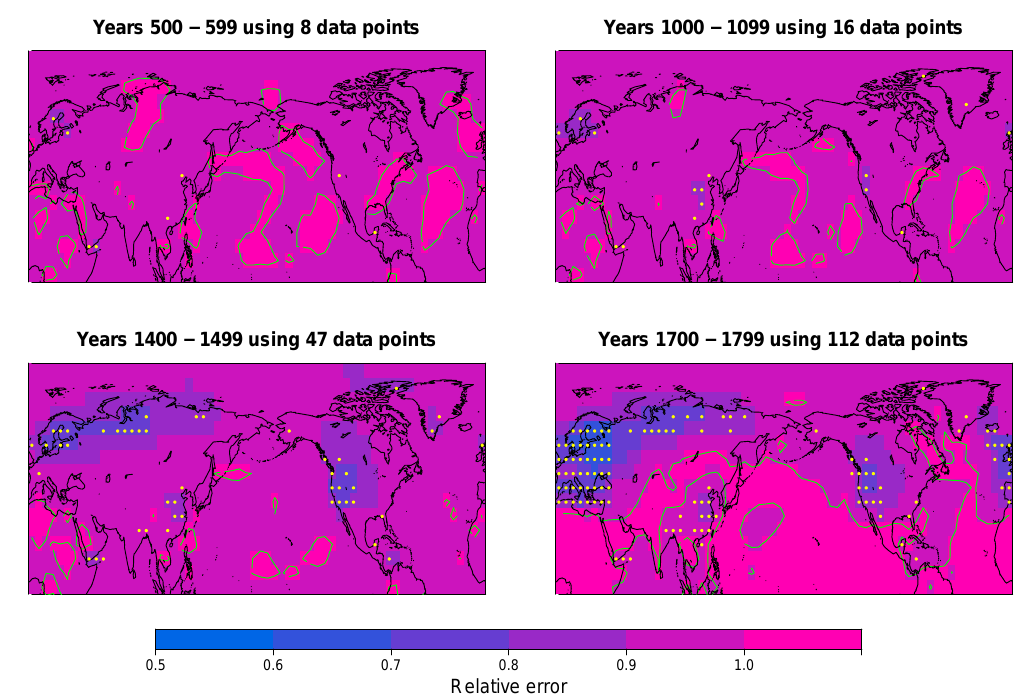
Fig. 4. Maps of normalised RMS reconstruction error for NH annual mean temperature anomalies in the case of internal variability, based on different number of proxy data points. Errors are normalised to standard deviation of climatology, with green contour indicating a normalised error of 1 (i.e. that the reconstruction is neither more nor less accurate on average than the prior climatological